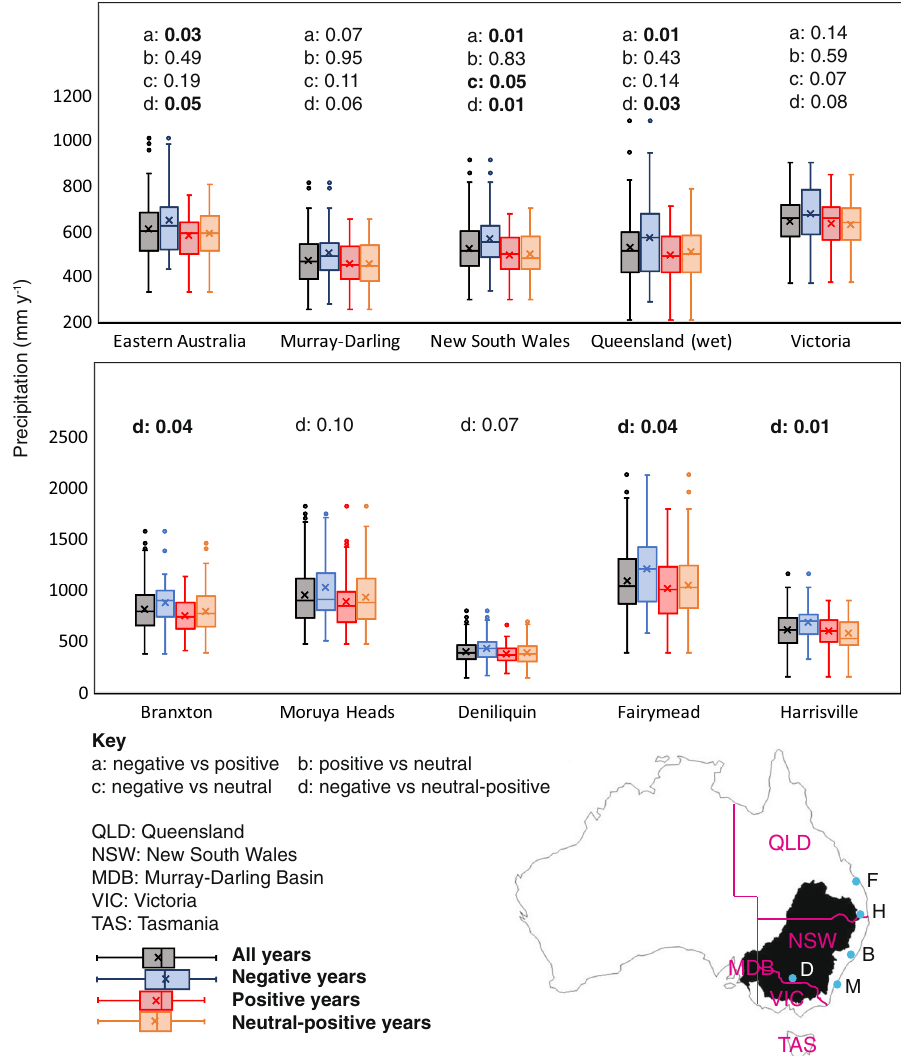
Fig. 4 Rainfall distributions by IPO phase for Australian domains and long rainfall stations. The rainfall distributions for each domain or station were calculated using annual (calendar year) total rainfall, which encompasses the water years for most regions except Queensland, which has a tropical (austral) summer wet season of October – April. Probabilities of no signi fi cant difference between rainfall distributions by IPO phase were tested using Welch ’ s t test, which is more robust to different sample sizes and variances than a standard Student ’ s t test. Note that there was little difference between the results for Welch ’ s versus Student ’ s t test. Probabilities for each domain are given above their respective boxplots ( p < 0.05 in bold), and the key identi fi es the distributions tested. Sample sizes for distributions over 1900-2014 are derived from the smoothed observed index (Fig. 1) and are negative: 39 y, positive: 47 y and neutral: 29 y. The key also indicates the domains tested, where Eastern Australia constitutes all the eastern states of Queensland, New South Wales (including the Australian Capital Territory), Victoria and the island of Tasmania. Annual total rainfall distributions in the catchment of Australia ’ s largest and most economically important river system, the Murray-Darling Basin (black) were also tested. Long rainfall stations are indicated with blue markers and station initial. Boxplot elements as per previous fi gures, with outliers (>1.5 × IQR) shown individually. See Table 2 for further statistics related to the distribution